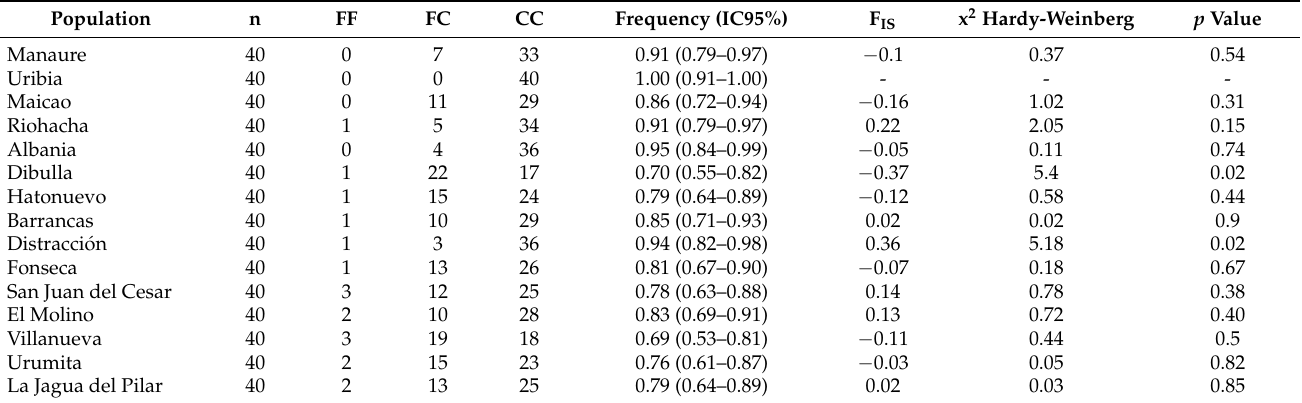
Table 3. Allele and genotype frequencies of F1534C in populations of Ae. aegypti from La Guajira,